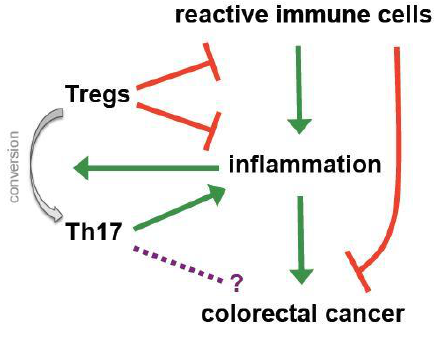
Figure 2. Regulatory T cells in colorectal cancer—friends and foes. The role of regulatory T cells (Tregs) in colorectal cancer is very complex and ambiguous. Chronic inflammation is strongly associated with intestinal carcinogenesis. Tregs efficiently control